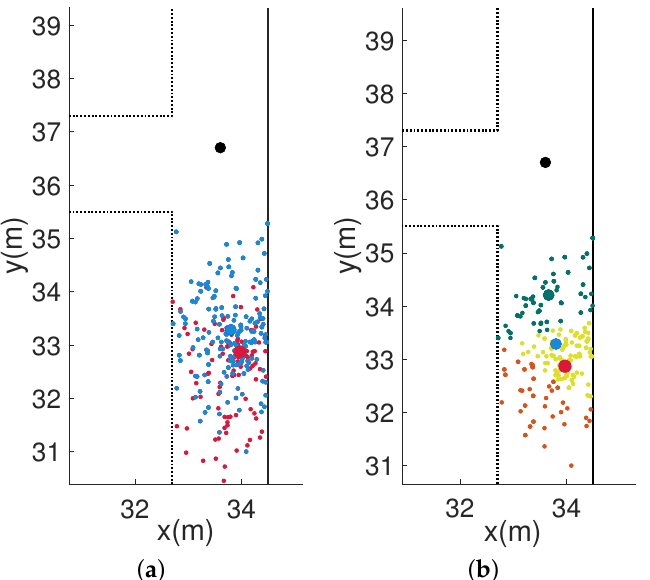
Figure 4. Corrected position information near the inflection point of the map. ( a ) Before position correction. ( b ) After position